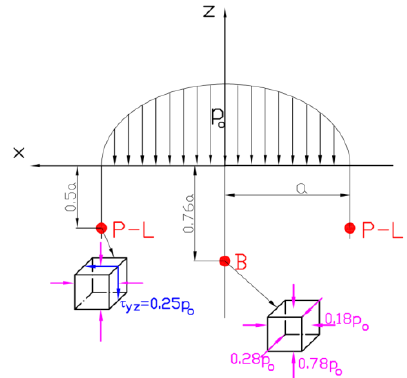
Figure 1. Location of characteristic points under surface, P-L—Palmgren–Lundberg points, B—Bielajev point.